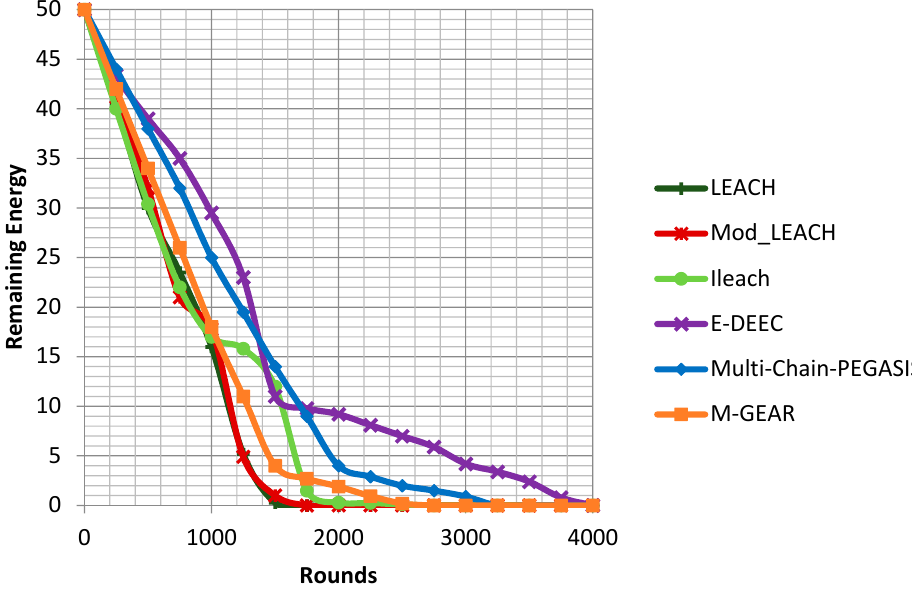
Figure 6. Energy versus rounds.